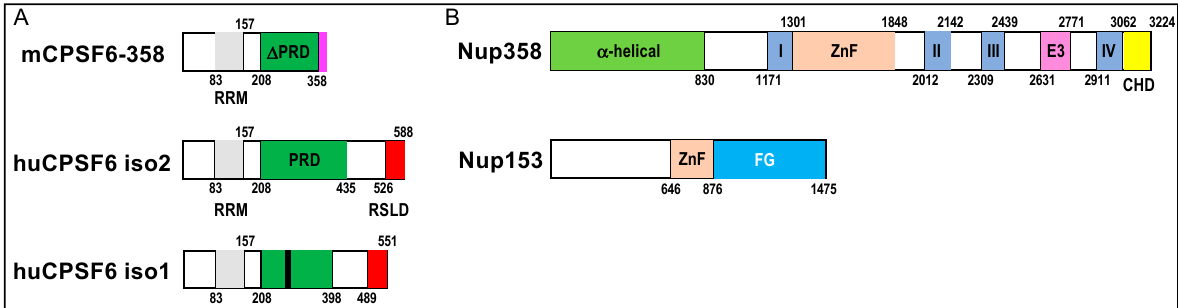
Figure 4. Domain organizations of CPSF6, Nup358, and Nup153. ( A ) Diagram of mCPSF6-358 restriction factor relative to human CPSF6 isoforms 2 and 1; the smaller isoform 1 is the form predominantly expressed in cells. Numbers demarcate domain boundaries. RRM, RNA recognition motif; PRD, proline-rich domain; RSLD, Arg/Ser-like domain. The region of the PRD that confers binding to CA is marked by a black line in human CPSF6 isoform 1. The original mCPSF6-358 construct harbored a heterologous 18-mer sequence (pink) at its C-terminus that did not impact anti-HIV restriction activity [94]. ( B ) Nup358 and Nup153 domain organizations. I–IV, Ran-binding domains I–IV; ZnF, zinc finger domains; E3, E3 ubiquitin ligase domain; CHD, cyclophilin-homology domain; FG, Phe-Gly peptide repeat domain.